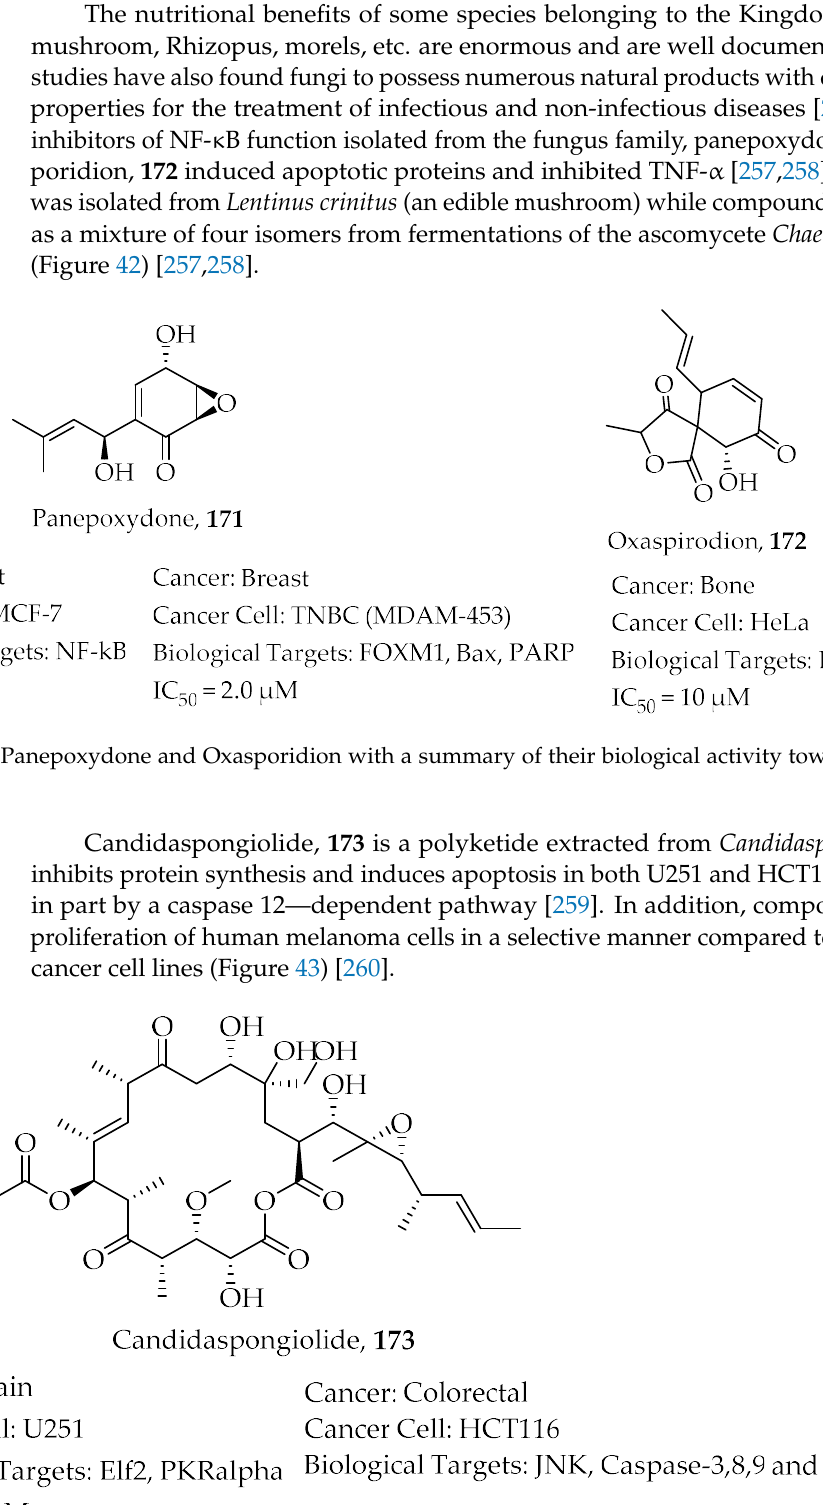
Figure 41. Structures of the triterpenoids Dichapetalins M, P, X and A, 7-Hydroxydichapetalin P, as well as Pacidusins A- D.